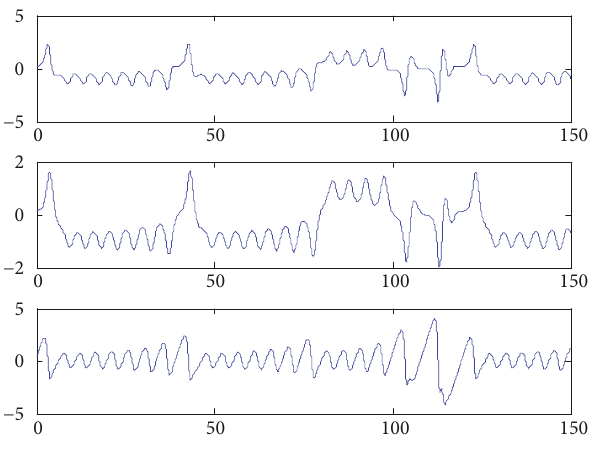
Figure 3: Time series diagram of system (7).